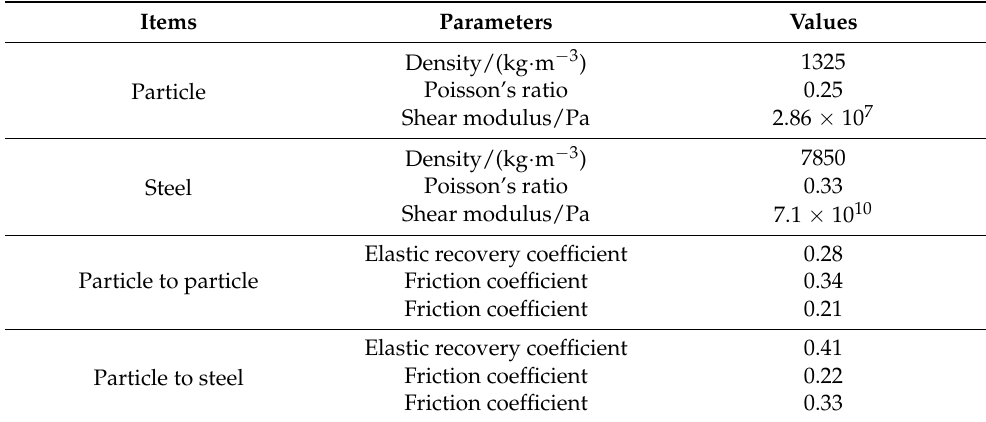
Table 1. DEM parameters used in the